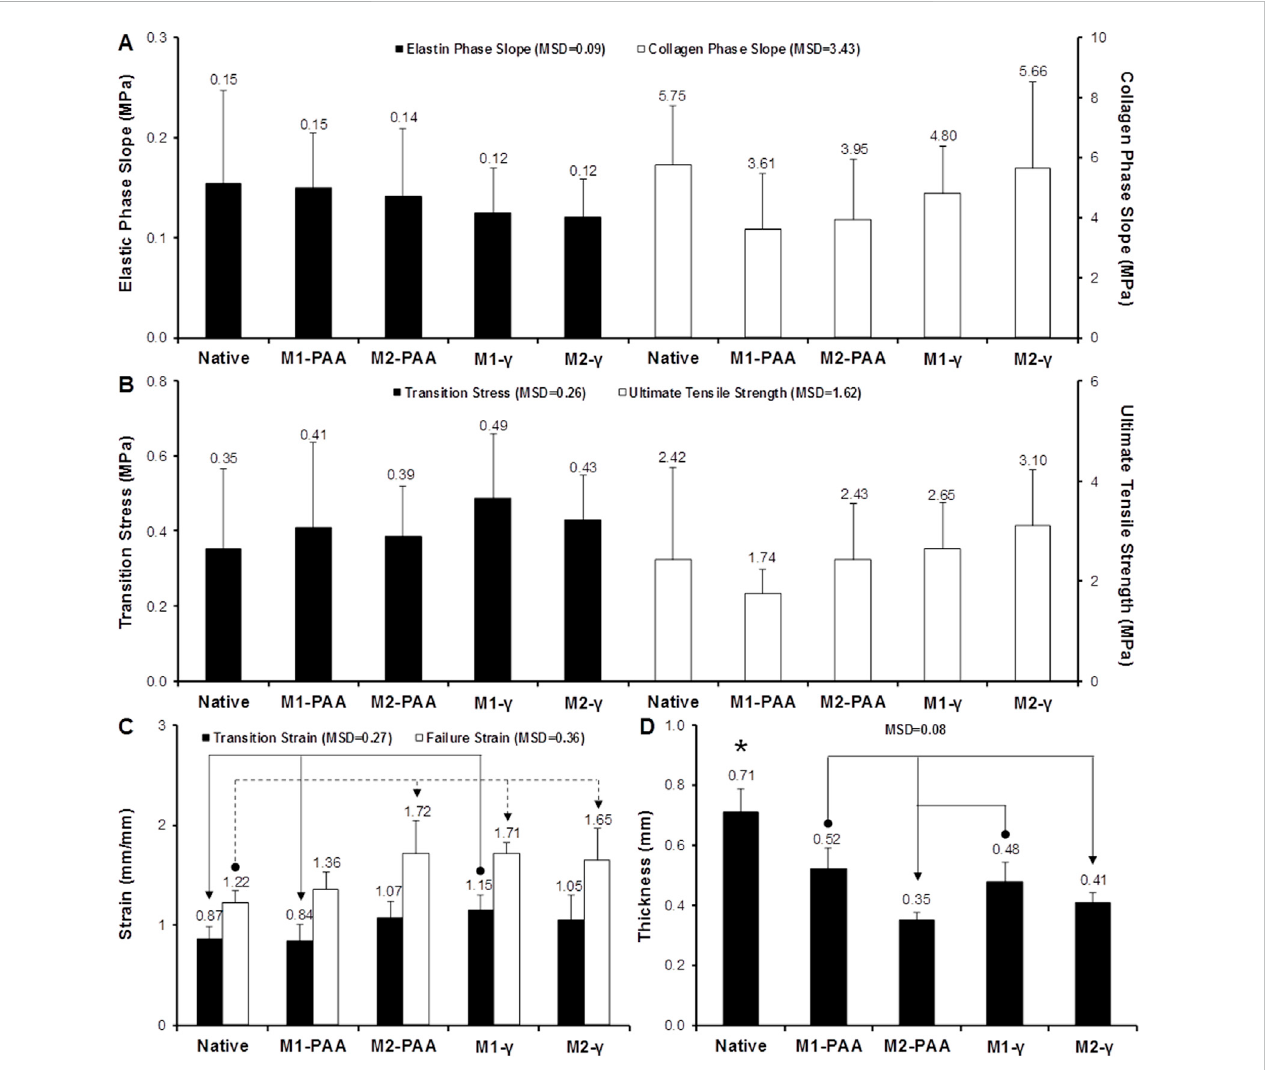
FIGURE 6 Biomechanics of native PTA and decellularized PTA scaffolds treated with (M2) or without (M1) RNase/DNase and sterilized with either PAA or γ - irradiation, tested axially. (A) Elastic and collagen phase slope; (B) transition stress and ultimate tensile strength; (C) transition and failure strain; (D) sample thickness.Datashowsmeans( n =6);errorbarsindicate95%C.I.;MSD:minimumsigni fi cantdifference;indicatessigni fi cantdifferencebetweenthenativeand the decellularized groups. Connectors indicate signi fi cant difference between originator and end arrow